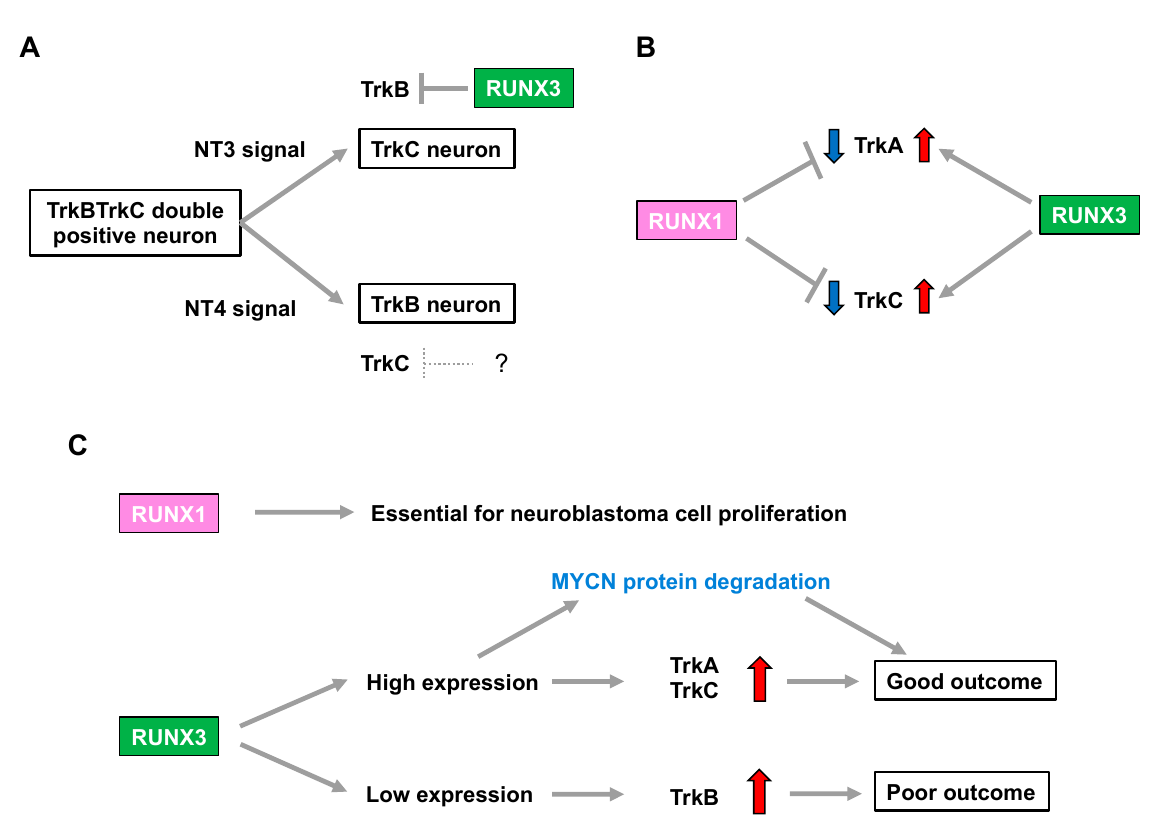
Figure 1. RUNX family is associated with neuroblastoma aggressiveness through regulation of Trk family expression. ( A ) Neurotrophin signals define the cell fate in development of the dorsal root ganglion. The question mark indicates a hypothetical repressor of TrkC. ( B ) RUNX1 and RUNX3 have opposite impacts on regulation of TrkA and TrkC expression. ( C ) RUNX 1 and RUNX3 influence neuroblastoma biology and patient prognosis.